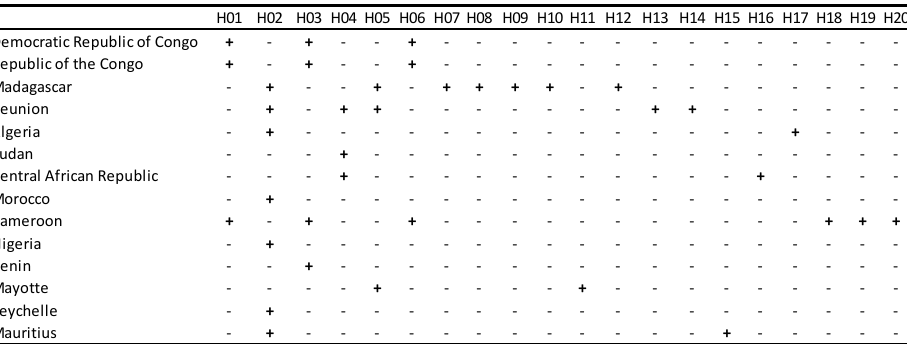
Figure 2. Maximum likelihood phylogenetic tree showing the relation between the